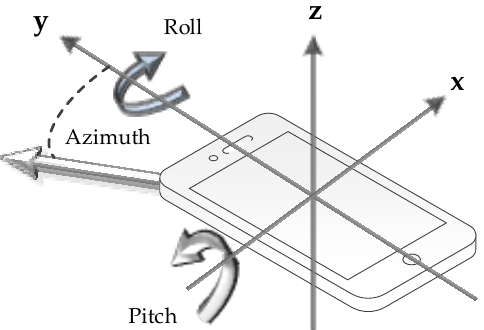
Figure 2. Visualization of the local axes and rotation angles, i.e. roll, pitch and